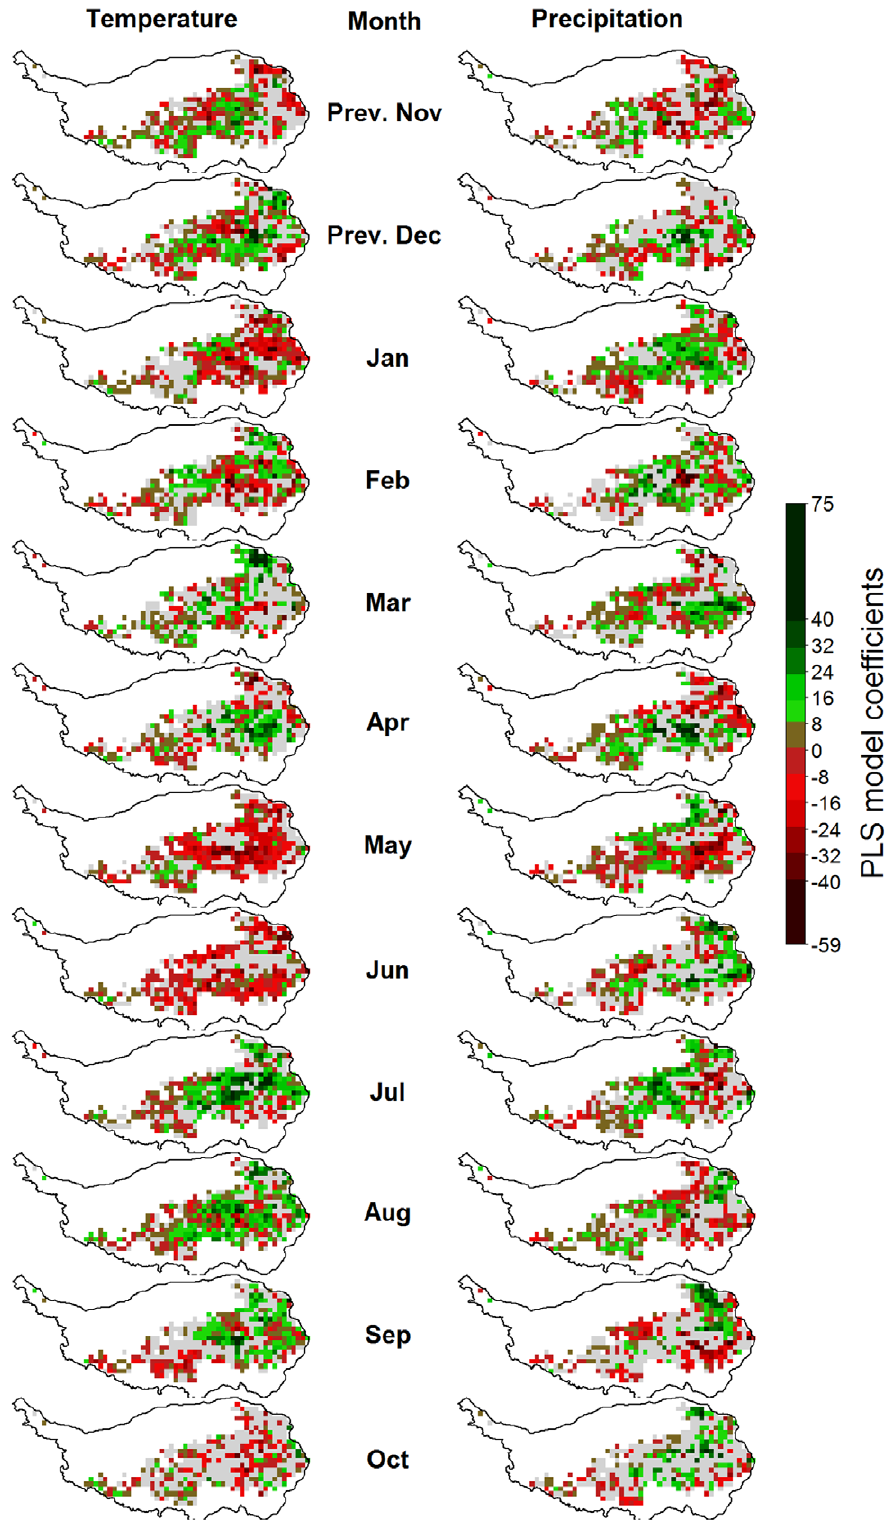
Figure 11. Correlations of monthly temperatures (left) and precipitation (right) with vegetation activity during grassland senescence (as measured by the NDVI) on the Tibetan Plateau, according to Partial Least Squares (PLS) regression. For each variable, pixels for which the variable-importance-in-the-projection score was , 0.8 are shown in gray. Pixels with insufficient data for PLS analysis are shown in white.